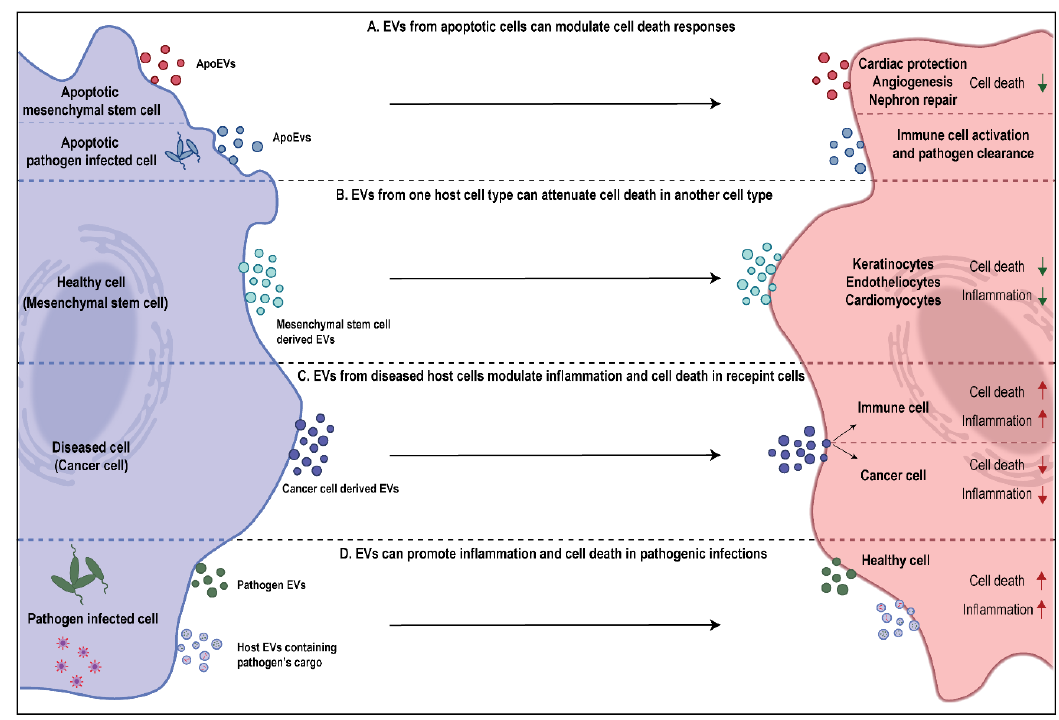
Figure 2. Context dependent roles of EVs in mediating cell death and inflammation. ( A ) ApoEVs have the ability to either attenuate or promote cell death. MSC derived ApoEVs have regenerative function whereas ApoEVs from pathogen in- fected cells induce activation of immune cells, leading to enhanced targeting and clearance of pathogen cells. ( B ) Similarly, EVs from healthy MSCs have regenerative function in preventing cell death and inflammation in various cell types. ( C ) Contrastingly, EVs from diseased host cells may function in different ways depending on the recipient cell. For instance, cancer cell derived EVs promote cell death and inflammation in immune cells but prevent cell death and inflammation in other cancer cells. ( D ) Infected cells can shed pathogen derived EVs or host EVs loaded with pathogen’s cargo. These EVs can promote cell death and inflammation in recipient host cells. 3. Role of EVs in Attenuating Cell Death Attenuation of cell death via extracellular vesicles has been studied in multiple mod- els (Table 1). It has recently been discovered that milk-derived EVs (MEVs) have a role in promoting gut health and development upon uptake by intestinal epithelial cells (IECs) [9]. MEVs from multiple sources, such as porcine, bovine and humans have been demon- strated to prevent cell death in IECs during oxidative stress and hypoxia and promote their survival and proliferation [47 – 49]. This ability of MEVs has been attributed to its cargo inhibiting p53 expression in IECs [50]. However, the role of MEVs in attenuation of cell death may not always be beneficial for the consumer. miR-148a and miR-21 which are a part of MEV cargo have been designated as oncomiRs due to their role in promoting vital cellular processes, such as proliferation and survival by inhibition of tumor suppres- sor genes [51 – 53]. Thus, the ability of MEVs to attenuate cell death could be detrimental too. Multiple studies have now demonstrated the ability of tumor cell-derived EVs in pro- moting survival and preventing cell death in recipient tumor cells (Figure 2). For instance, exosomes from N-myc amplified neuroblastoma cells were found to enhance survival by inducing chemoresistance in non-N-myc amplified cells, preventing doxorubicin induced apoptosis [54]. Furthermore, in other studies using glioblastoma models, it has been shown that exosomes shed by apoptotic tumor cells were able to confer survival ad- vantage to the surviving glioblastoma cells by transferring spliceosome components [55]. Another model where EVs attenuated cell death, that continues to be increasingly defined with studies, is that of stem cells. The therapeutic nature of mesenchymal stem cells (MSCs) due to paracrine signaling is well established [56]. Recently, it was observed that